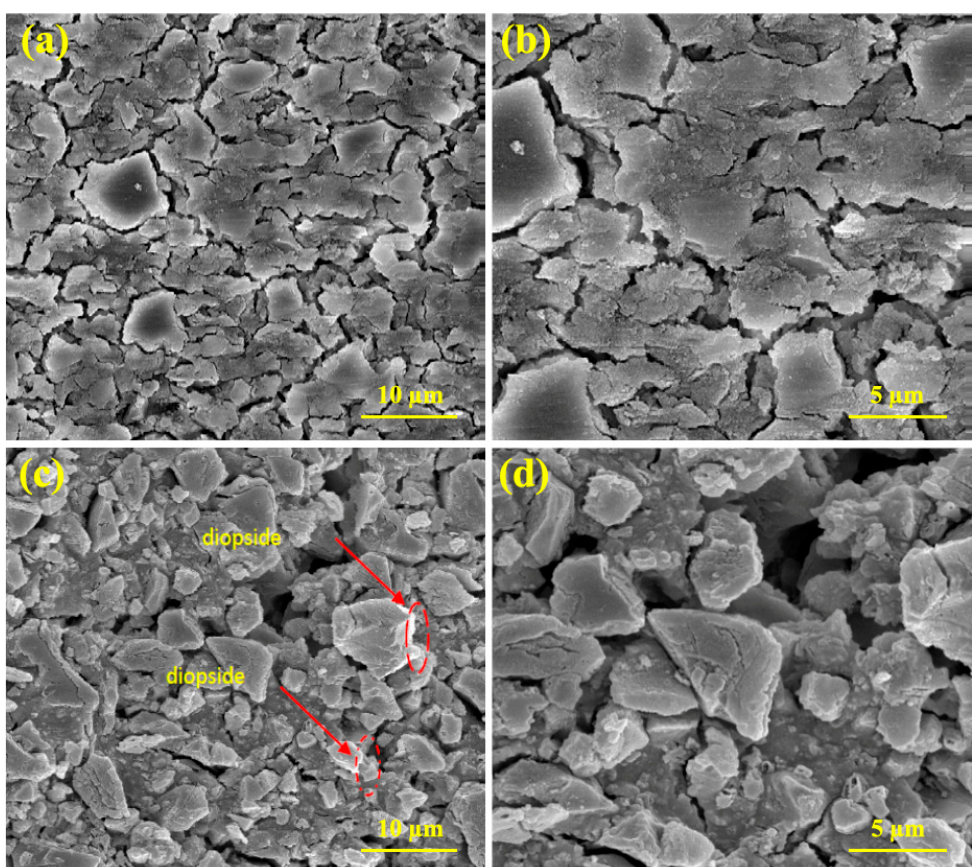
Figure 11. FESEM images of glass ionomer and glass ionomer nanocomposites with 4 wt% diopside: ( a , b ) Glass ionomer nanocomposite, and ( c , d ) Glass ionomer diopside nanocomposite at different magnifications.